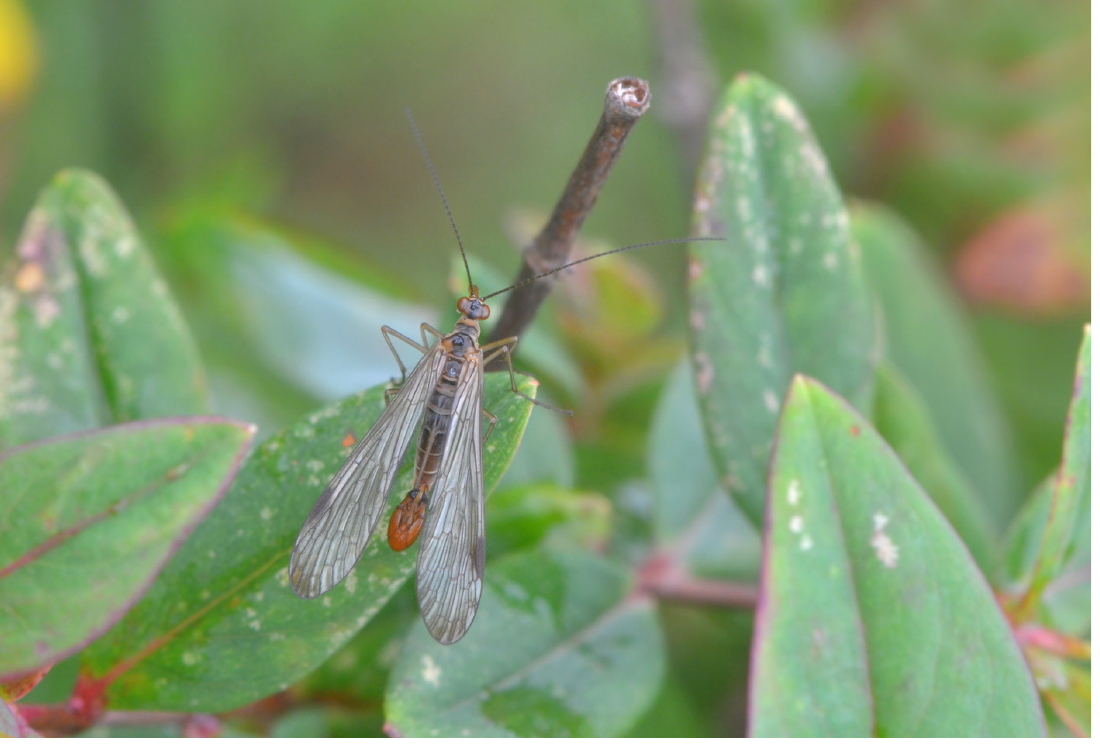
Fig. 1. Neopanorpa luojishana Wang & Hua sp. nov., living male. Photo by Ji-Shen Wang from Mt. Luoji, Sichuan,